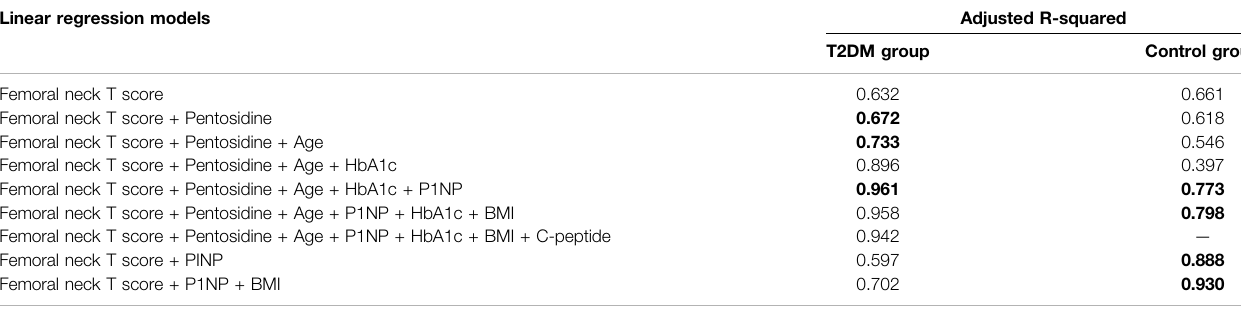
TABLE 3 | Multiple linear regression models of the T2DM and control groups. Linear regression models